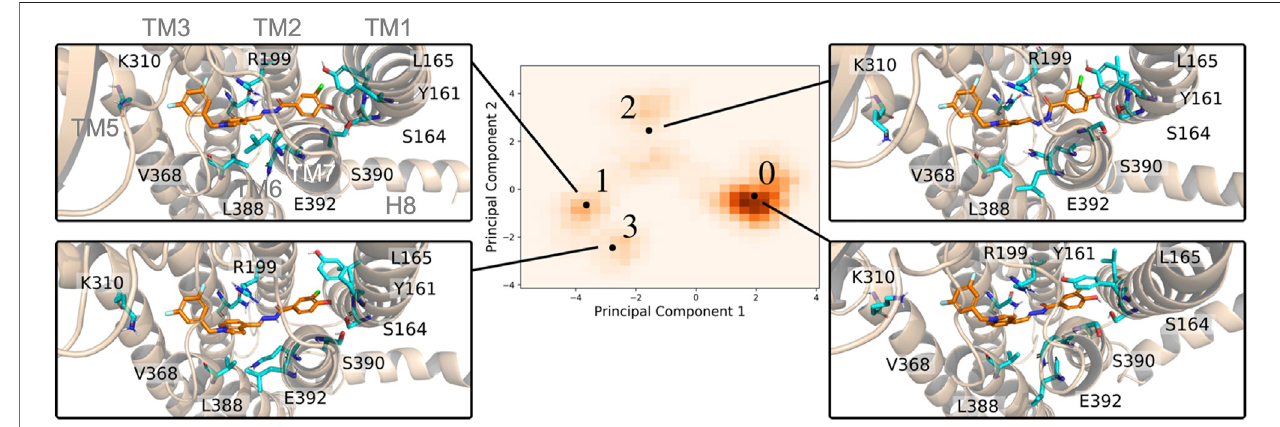
FIGURE 2 | Four representative PAC1R conformations using in EDED reveal important changes in the binding pocket. The protein is shown in cartoon and the reference ligand is shown as sticks. The histogram of all trajectory frames projected onto the fi rst two principal components of residues within the ligand-binding pocket of PAC1R. Black dots labelled with numbers from 0 to 3 are the representative structures (S0, S1, S2, and S3) determined by the K -means clustering